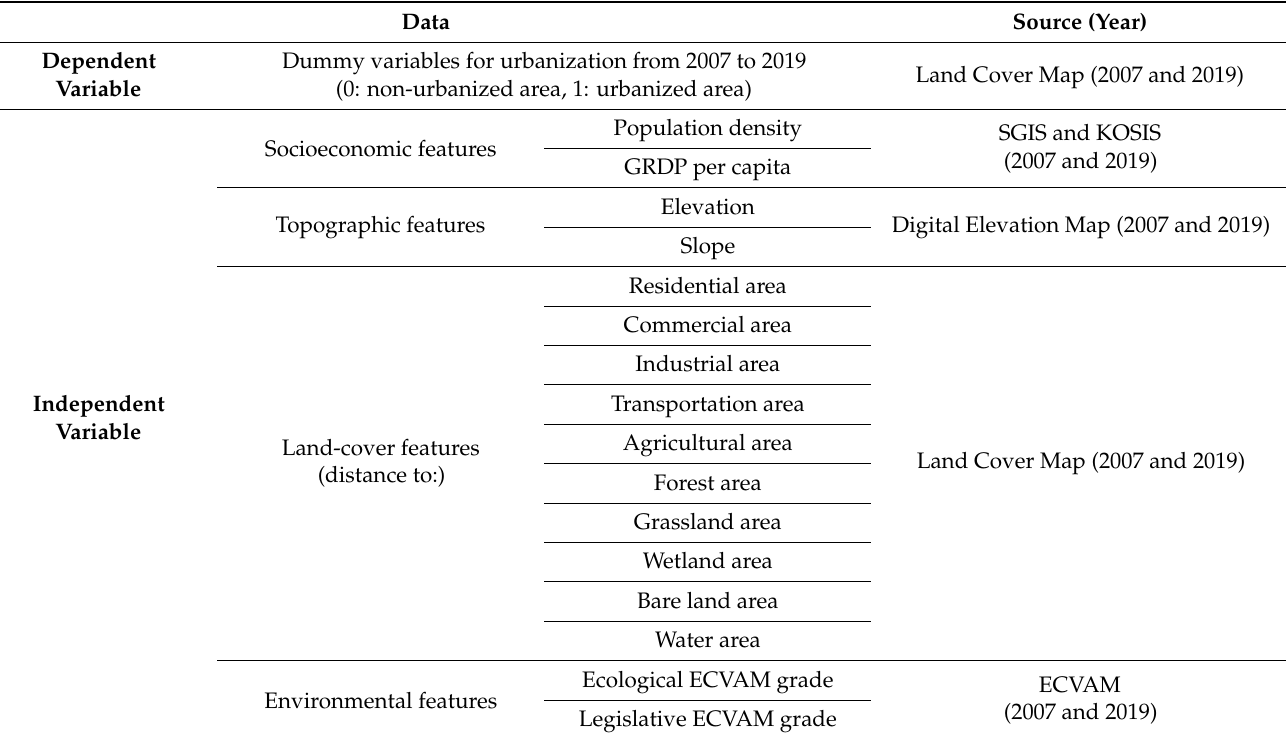
Table 1. Description of variables used in the study.